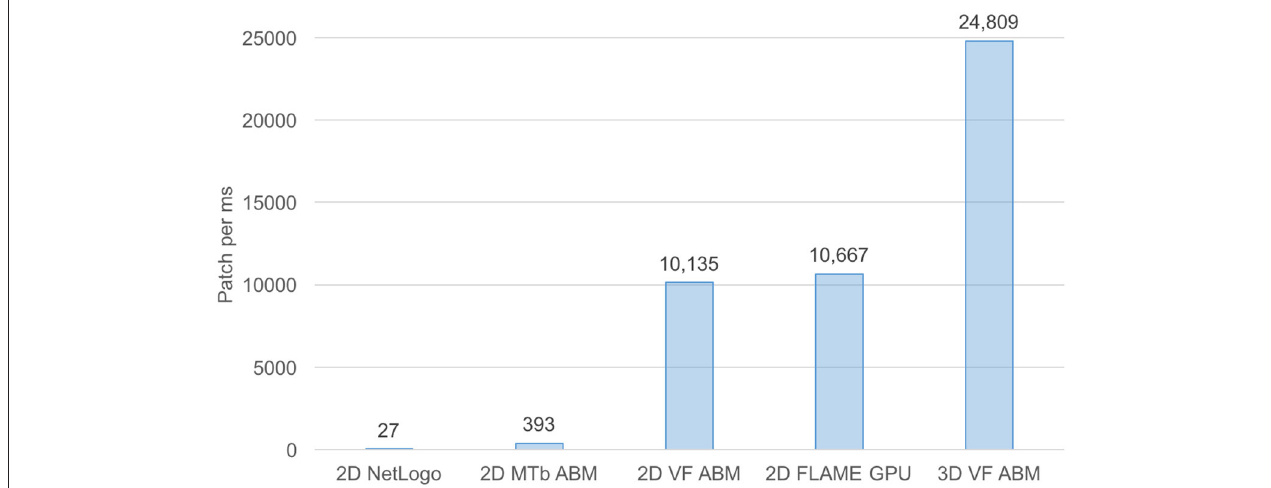
FIGURE 7 | Processing power of 3D VF-ABM vs. existing work comparison. This bar chart compares workload and execution time in terms of number of patches (i.e., lattice points, grid points, stationary cells) per ms between the 3D VF-ABM to other bio-simulation ABM work. Notice that the 3D VF-ABM is capable of processing 25K patches/ms, or about 900x, 63x, 2.3x, and 2.4x more patch processing power than NetLogo, MTb ABM ( D’Souza et al., 2009), FLAME GPU immune system ABM (de Paiva Oliveira and Richmond, 2016), and the earlier 2D VF-ABM work (Seekhao et al., 2016).